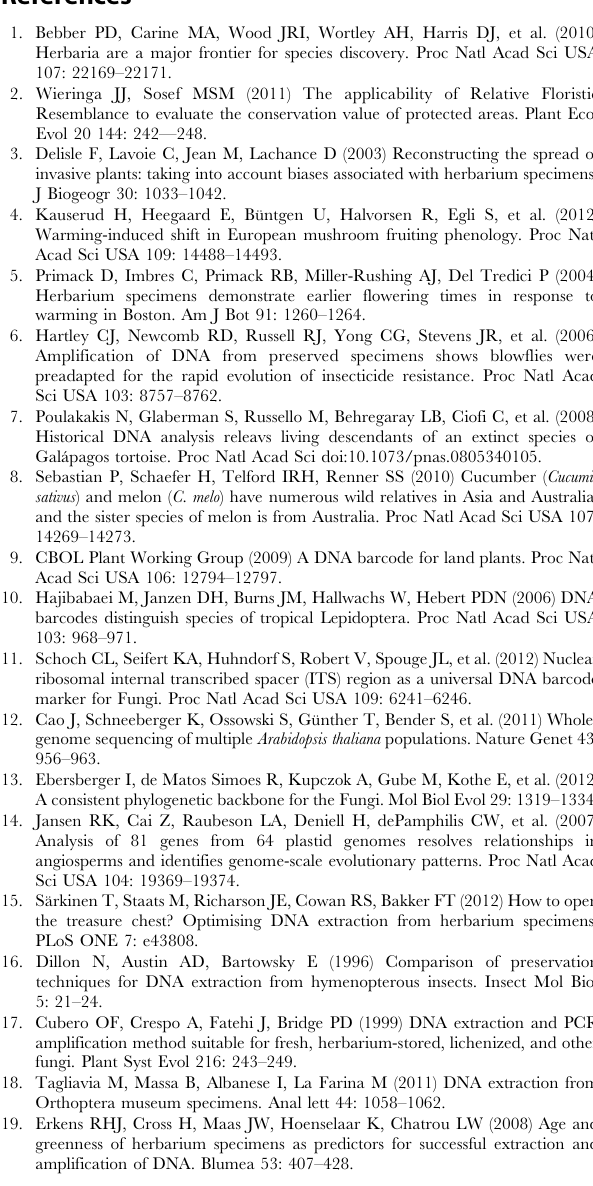
Table S1 Percentage, mean and maximum read cover- age over all nucleotide positions for chromosomes, scaffolds or linkage groups ( LG ) . Table S2 Specimen information. Table S3 Average nucleotide mis-incorporation rates ( substitutions per base ) observed in fresh and collection DNA. Table S4 ANOVA on nucleotide mis-incorporation rates for each of the six nucleotide substitution types. Table S5 Genotyping and total number of SNPs and indels in coding sequences ( CDS ) .